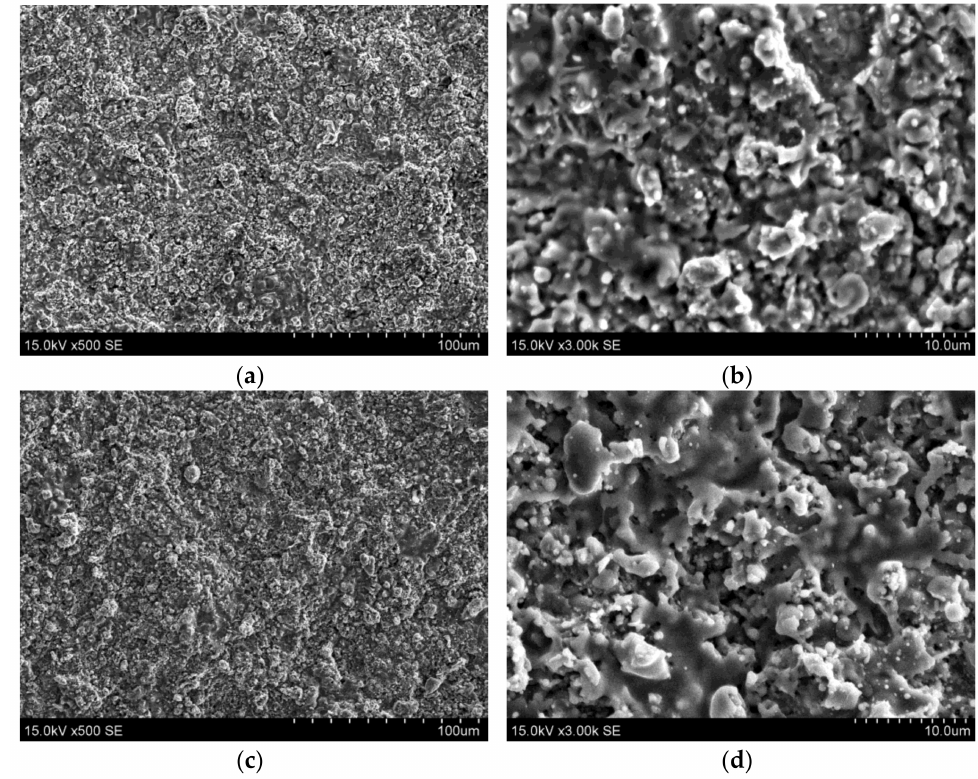
Figure 1. Surface morphology of ( a , b ) Cr 2 O 3 and ( c , d ) Cr 2 O 3 -SiO 2 -TiO 2